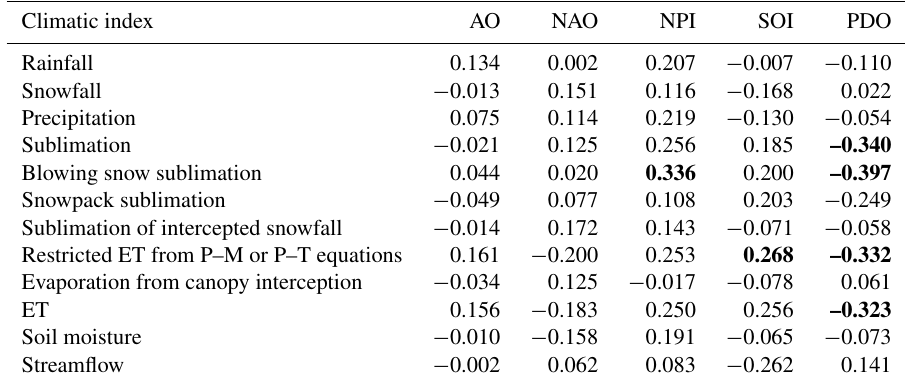
Table 5. Pearson correlation coefficient between basin-scale mass fluxes and climatic indexes, using water year values (October–September). Correlation coefficients with p values ≤ 0 . 05 are in bold. Climatic